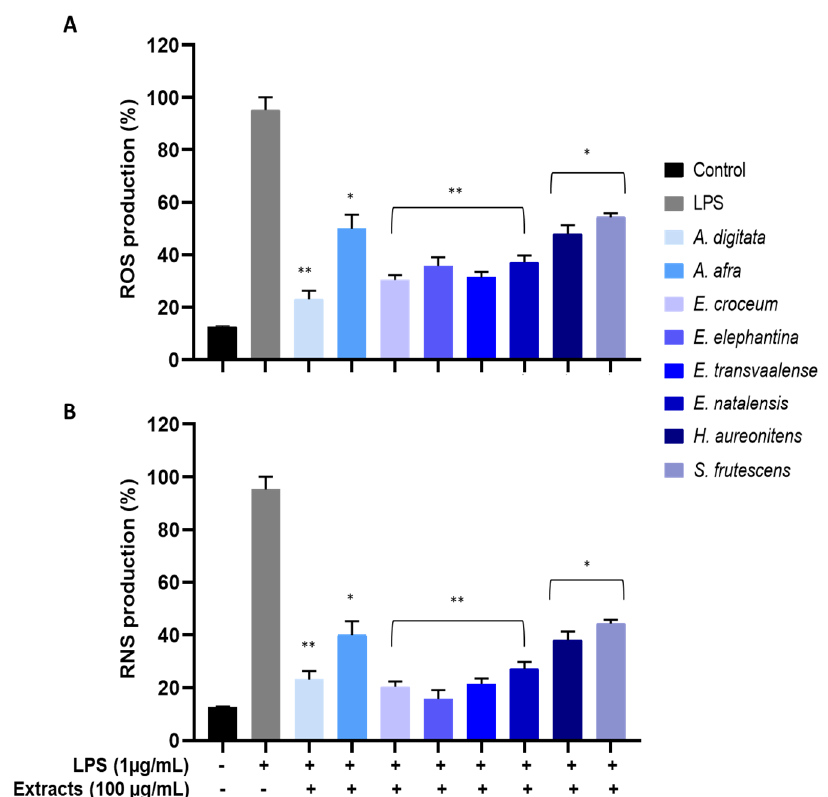
Figure 3. Intracellular reactive oxygen species (ROS) ( A ) and reactive nitrogen species (RNS) ( B ) scavenging activities of eight extracts against LPS-induced oxidative stress in Vero cells. Statistical analysis: one-way ANOVA with Duncan multiple range test for means ± SD (*) p < 0.05, (**) p < 0.01 was considered to indicate statistically significant difference compared to the LPS-treated group.